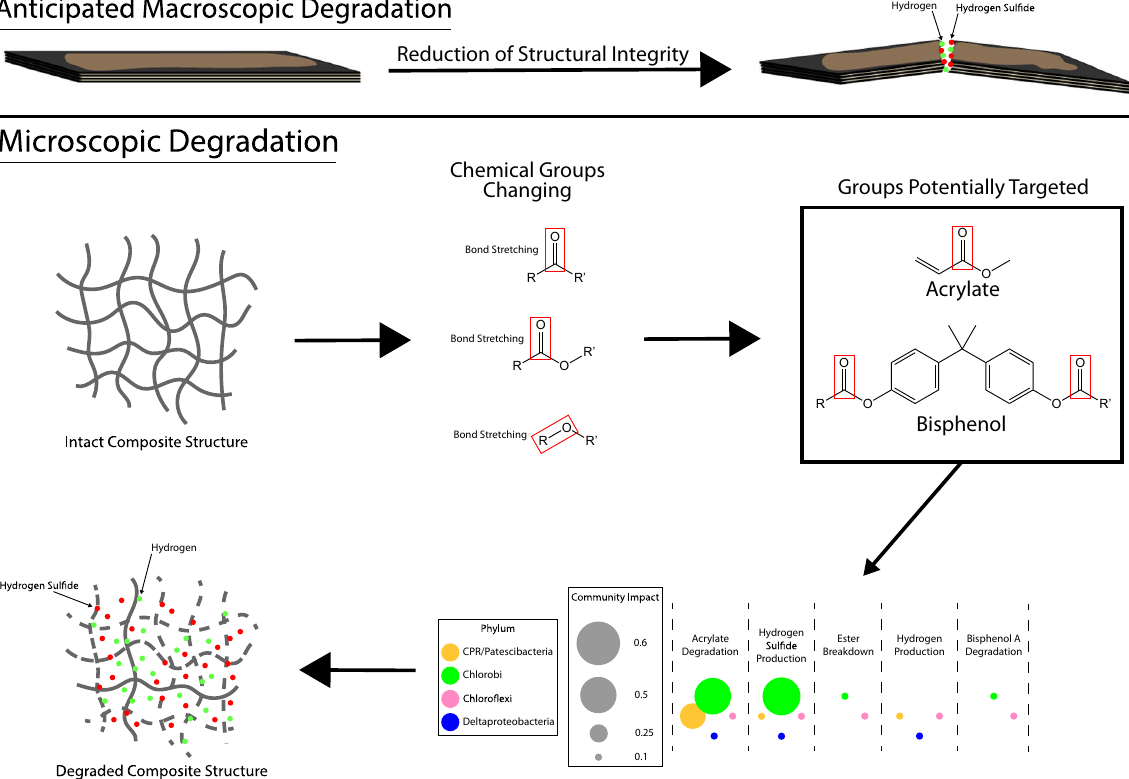
Fig. 9 Macroscopic and microscopic degradation of polymer composite structure. Macroscopic degradation, which manifests in reduction of structural integrity, is shown as the progression from an intact composite to an exaggeratedly broken composite. Microscopic degradation manifests itself as breaks in the polymer chain, which is in fl uenced by microbial metabolisms. Chemical groups being modi fi ed were identi fi ed through FT-IR and were extrapolated to groups within compounds present in the composite material. “ Community Impact ” refers to a value that is the product of the relative abundance of a certain taxon and the percentage of MAGs capable of performing a speci fi c function. For community impact, values of ≤ 0.1, the size of the circles is